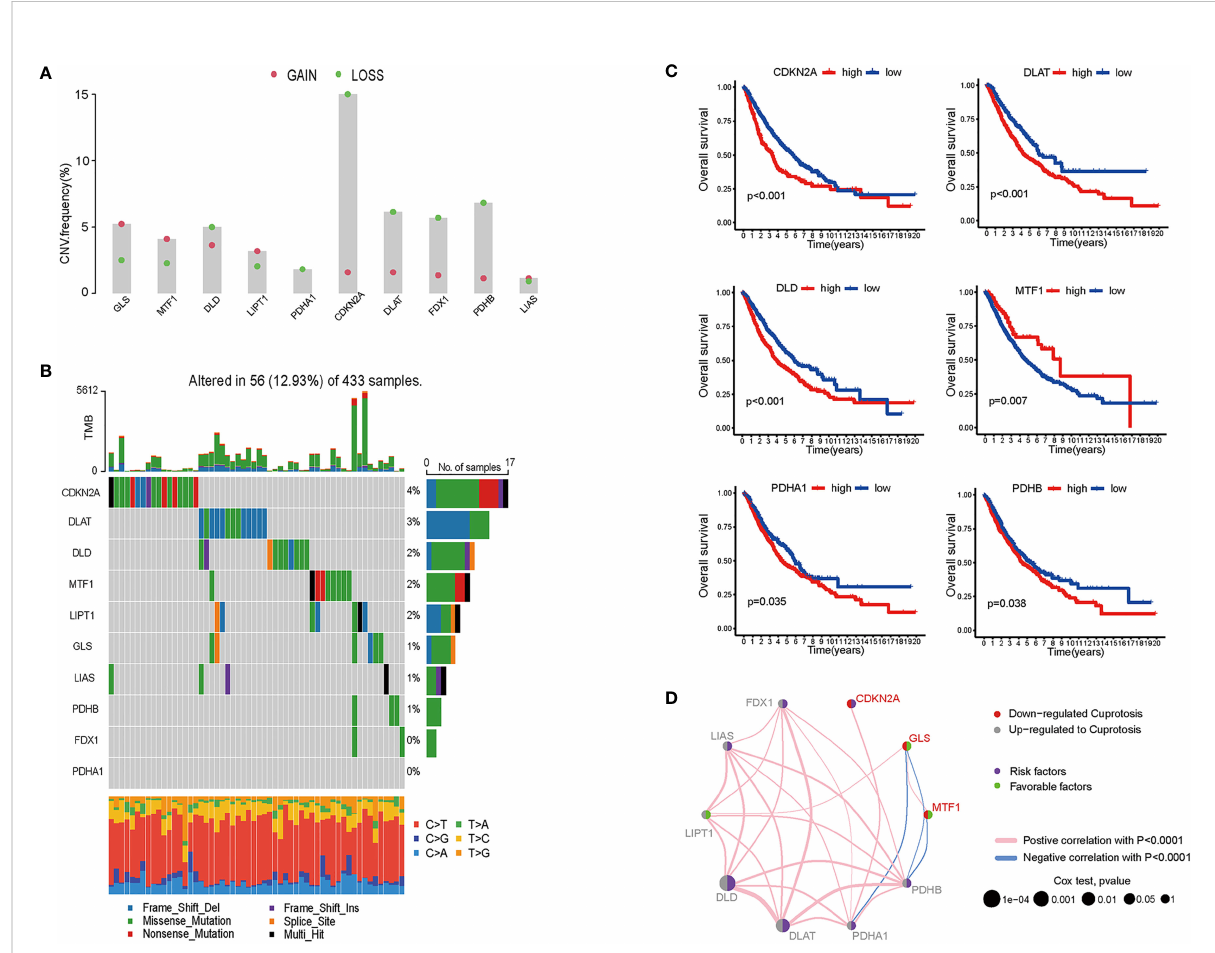
FIGURE 1 Genomics and transcriptomics-based bioinformatic analysis on cuproptosis-related genes in lung adenocarcinoma. (A) CNV frequencies showed the loss and gain of ten cuproptosis biomarkers. (B) TMB of cuproptosis biomarkers and the proportion of base-pair alterations in LUAD samples. (For exmale, C>T: cytidine being replaced by adenosine, and so on in a similar fashion.) (C) ROC curves showed overall survival of single cuproptosis-related gene expression in LUAD patients. (D) Association between cuproptosis biomarkers expression and LUAD risks. (For example, DLD was up-regulated in LUAD samples; DLD expression was a risk factor for LUAD patients; and DLD expression was positively correlated with LIPT1, LIAS, FDX1, PDHB, PDHA1, and